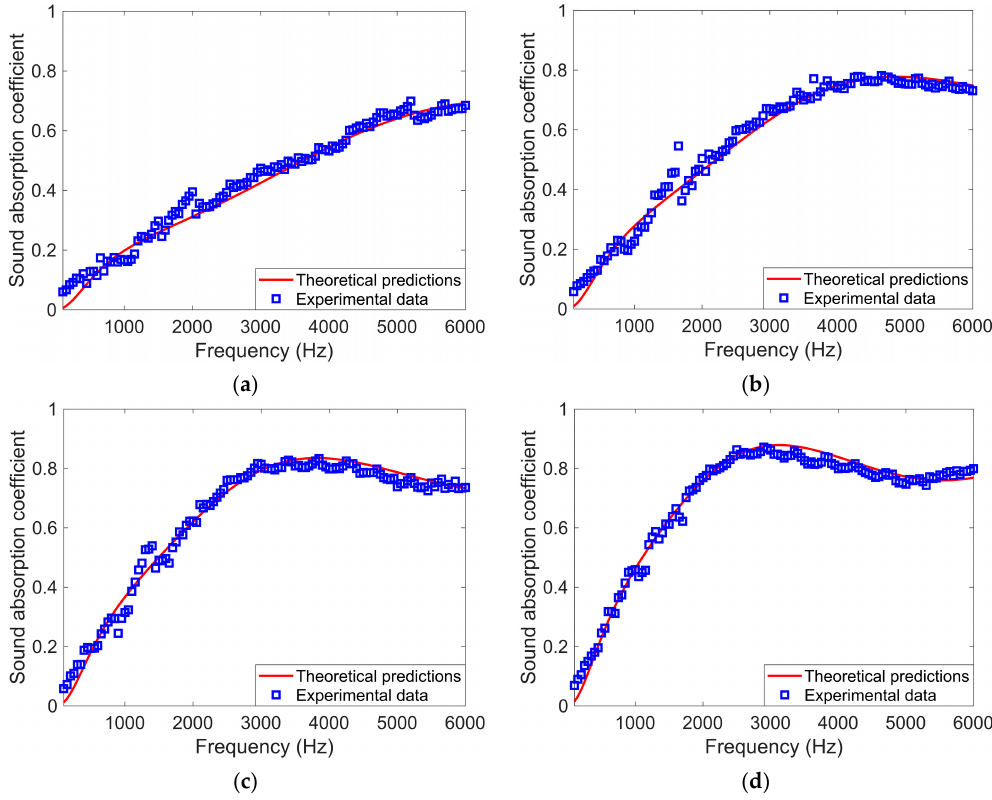
Figure 6. Comparisons of the theoretical predictions and the experimental data of sound absorption coefficients of the porous metal ( a ) with a thickness of 15 mm, ( b ) with a thickness of 20 mm, ( c ) with a thickness of 25 mm, and ( d ) with a thickness of 30 mm.